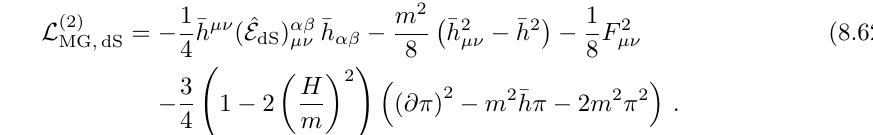
(helicity-2 and -1 modes), sick theory ,